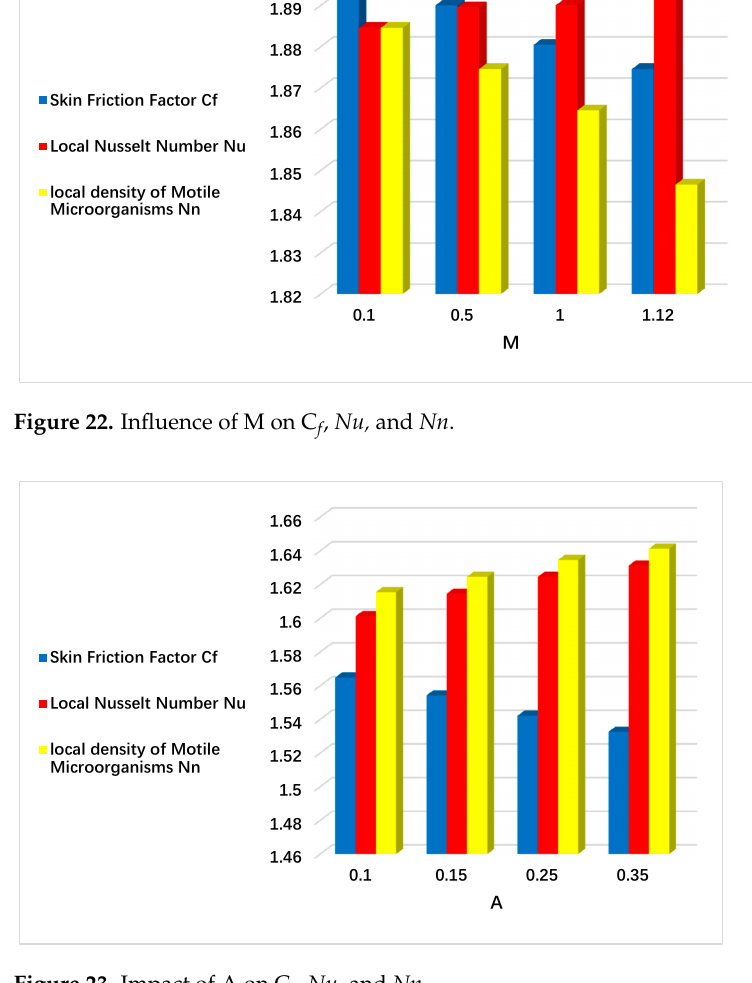
Figure 23. Impact of A on C f , Nu, and Nn .